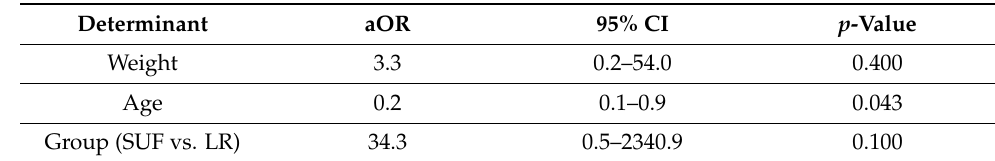
Table 3. Analysis of the determinants of fentanyl administration in a multivariate logistic regres- sion model.